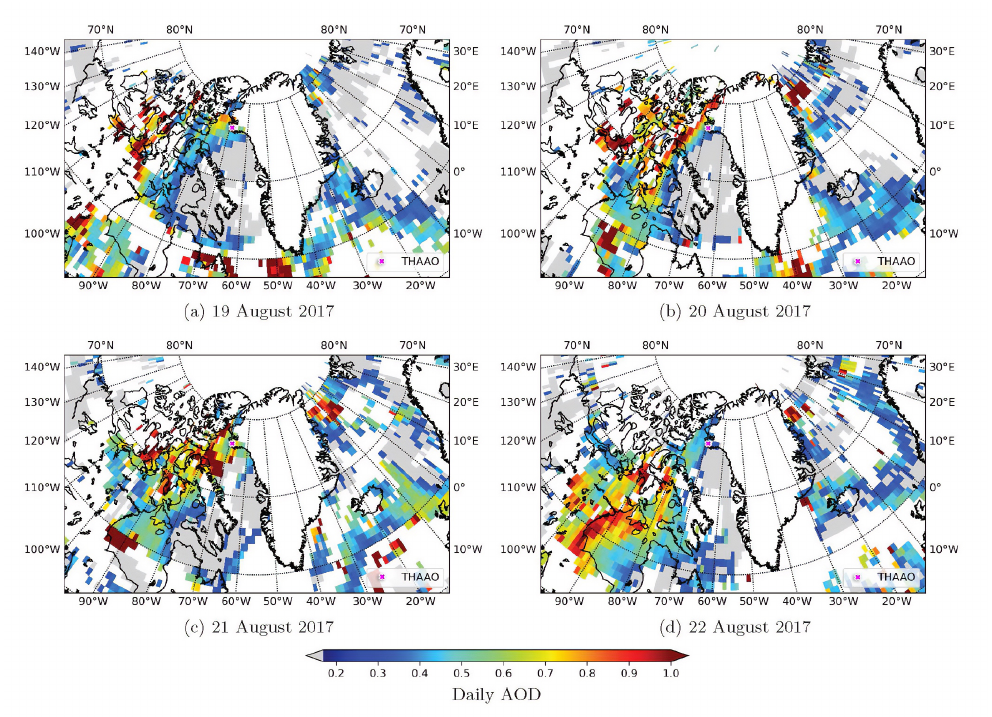
Figure 5. MODIS daily AOD spatial distribution at 550 nm for 19–22 August 2017. The grey-shaded area represents pixels with AOD values below the 90th percentile threshold value (0.17). White areas represent pixels where no MODIS AOD data were available. See text for further details.